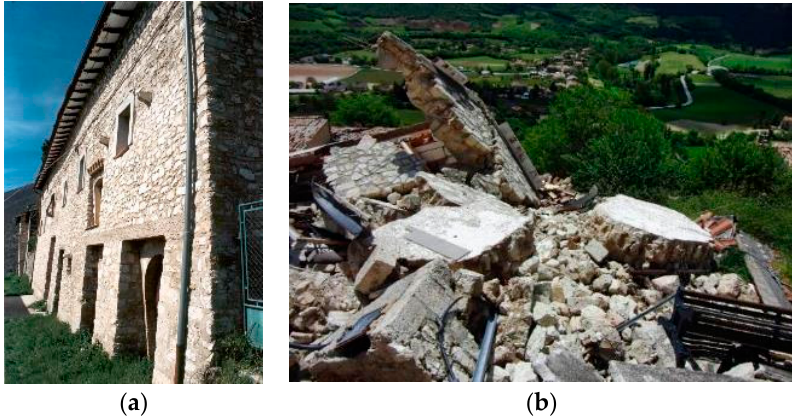
Figure 6. Example of a historic masonry building ( a ) retrofitted in the past; and ( b ) its total collapse after the main shock in 2016.